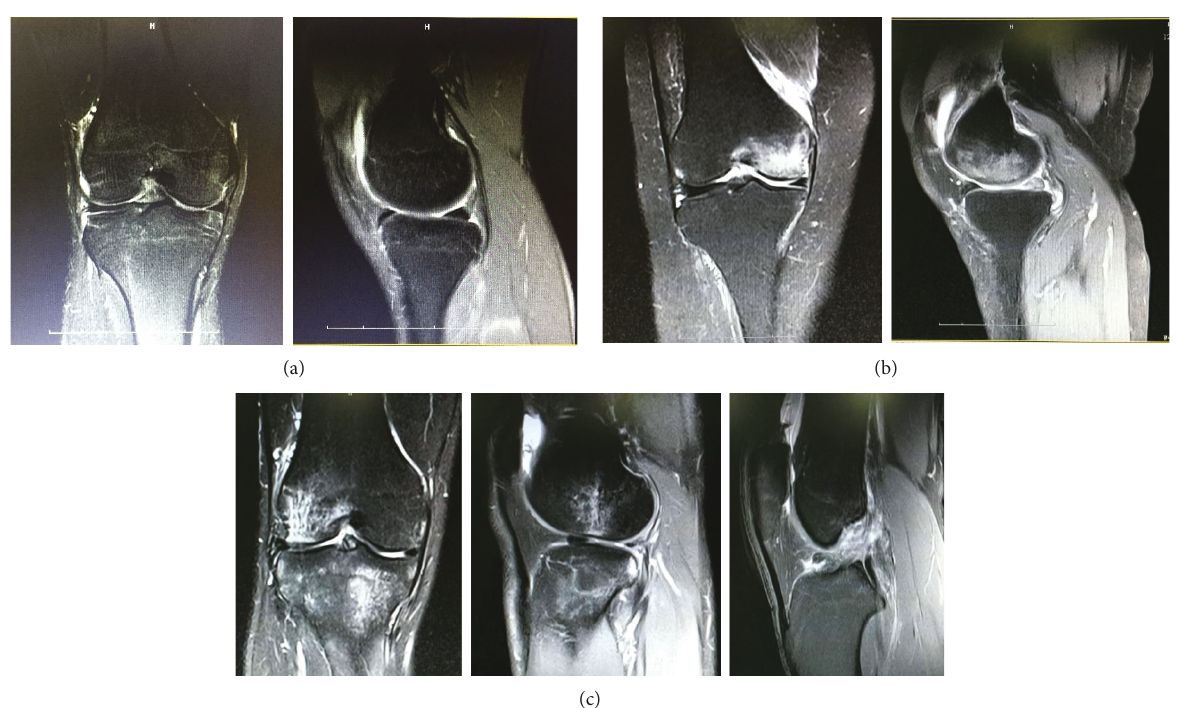
Figure 11: (a) Case 1: male, 21 years old, long distance runner, right knee pain, and swelling after knee longitudinal impact injury in one long- distance race. MRI showed that medial femur and medial tibia had mild bone bruise, bone marrow edema, and mild joint e ff usion. (b) Case 2: male, 77 years old, right knee pain, and swelling after one falling longitudinal impact injury at one meter high. MRI showed widely that medial femoral condyle had bone marrow injury and edema. Medial tibia had mild bone bruise and joint e ff usion. (c) Case 3: male, 22 years old, soldier, right knee pain, swelling, and movement dysfunction after knee longitudinal impact injury in one military training. MRI showed widely that medial tibia had bone marrow edema, meniscus injury, and rupture of anterior cruciate